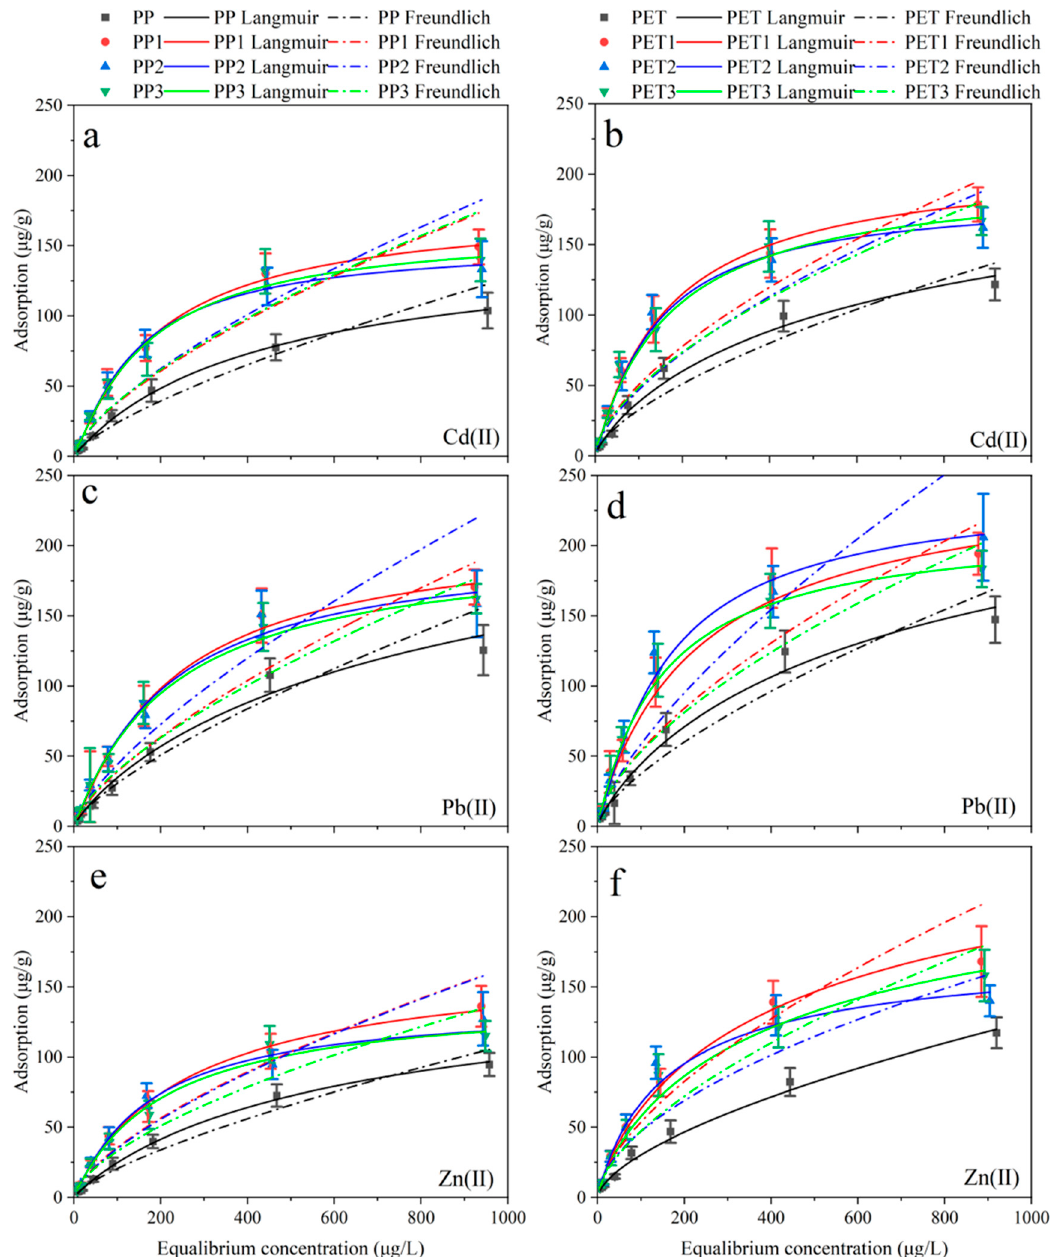
Figure 4. Adsorption isotherms of the Cd(II) ( a , b ), Pb(II) ( c , d ) and Zn(II) ( e , f ) for plastic debris. PP and PET: virgin plastic; PP1 and PET1: biofilm-covered plastic in Xuanwu Lake; PP2 and PET2: biofilm-covered plastic in Donghu Lake; PP3 and PET3: biofilm-covered plastic in the Qinhuai River.